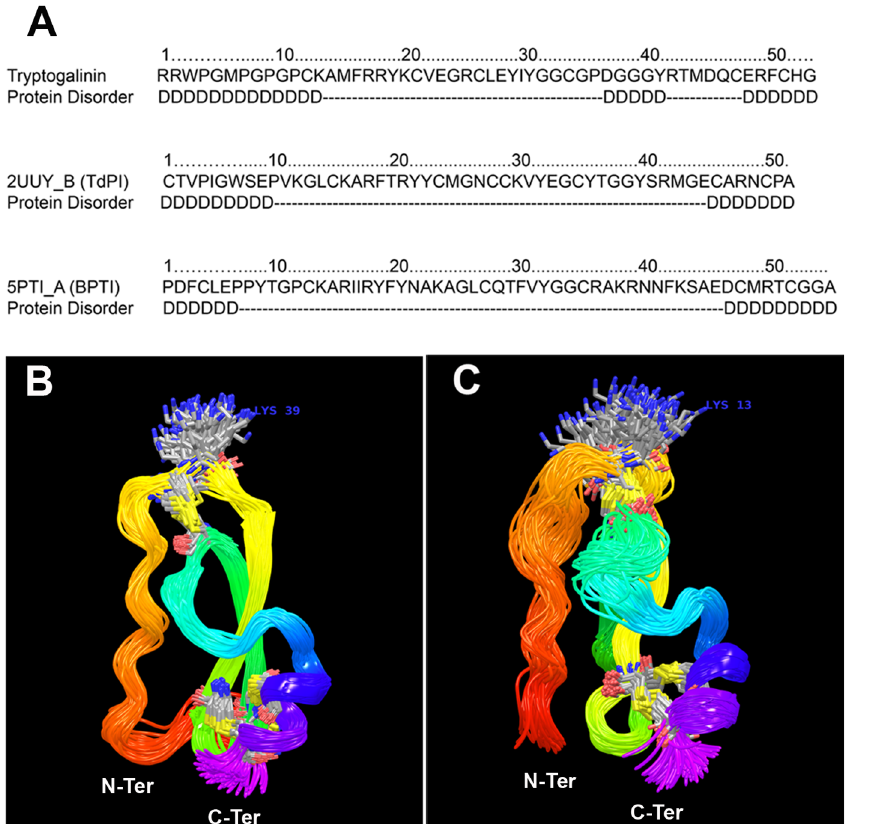
Figure 6. A–C. Intrinsic protein disorder and MD simulations. Intrinsic regional protein disorder (A) predicted by the GeneSilico MetaServer [37] for tryptogalinin, TdPI (PDB: 2UUY chain: B) and BPTI (PDB: 5PTI), respectively – ‘D’ represents the disordered region and dashes are ordered. A total of 100 snapshots (i.e., conformations) during last 40 ns of MD for TdPI (B) and tryptogalinin (C).